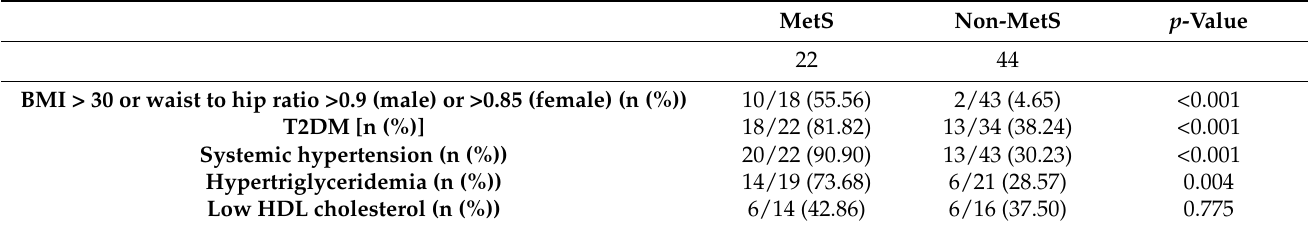
Table 1. Distribution of metabolic abnormalities in MetS vs. non-MetS iCCA patients. MetS Non-MetS p -Value 22 44 10/18 (55.56) 2/43 (4.65)